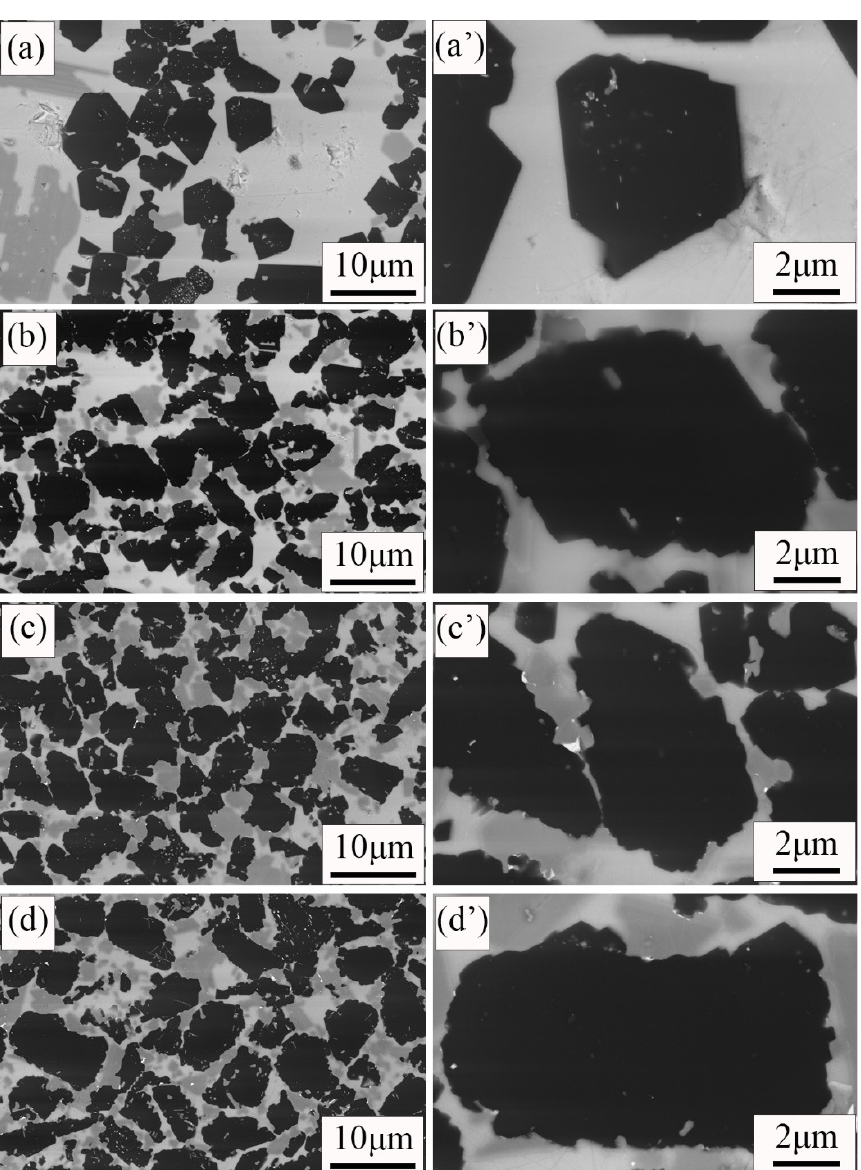
Figure 6. SEM images of the RBBC composites with different carbon contents. ( a , a ′ ) 0; ( b , b ′ ) 5 wt%; ( c , c ′ ) 10 wt%; ( d , d ′ ) 15 wt%. ( c , c (cid:48) ) 10 wt%; ( d , d (cid:48) ) 15